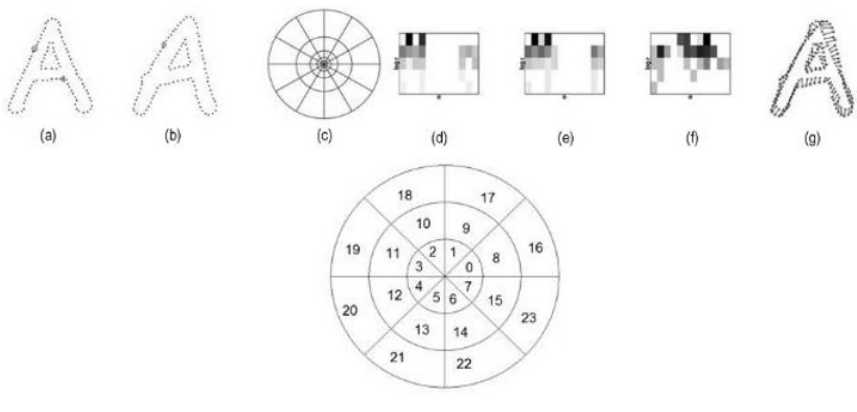
Fig. 1. Similarity measures for images of shorthand